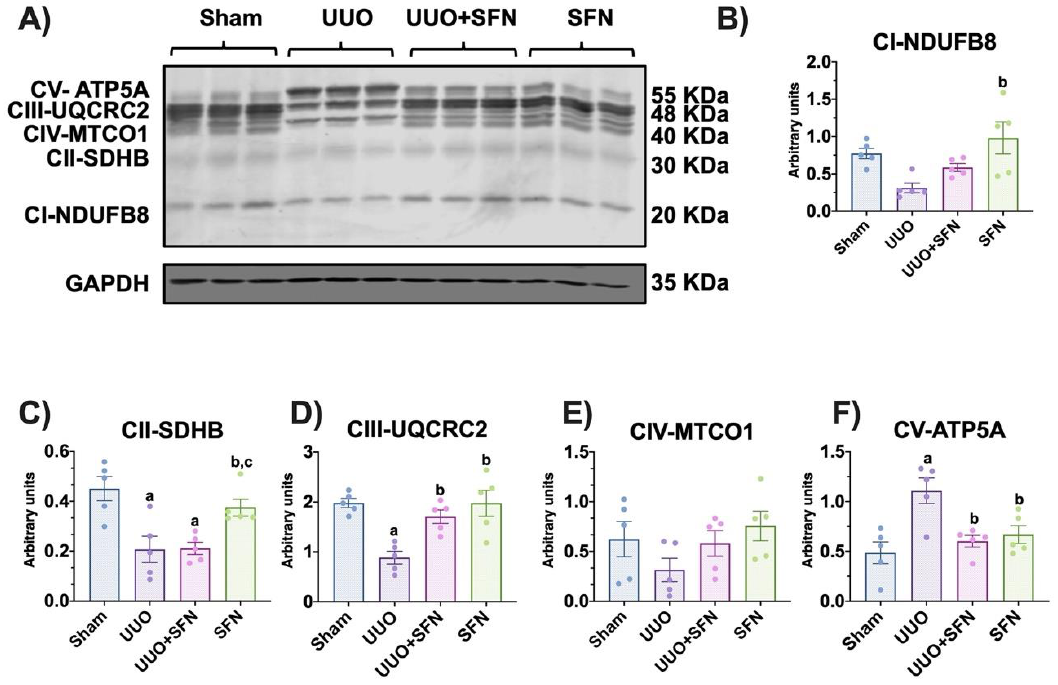
Figure 4. Effect of sulforaphane (SFN) on the levels of subunits of the electron transport system (ETS) complexes in the unilateral ureteral obstruction (UUO) model. ( A ) Representative immunoblotting and densitometric analysis of the levels of ( B ) the reduced form of nicotinamide adenine dinucleotide ubiquinone oxidoreductase subunit B8 (CI-NDUFB8), ( C ) succinate dehydrogenase complex iron-sulfur subunit B (CII-SDHB), ( D ) ubiquinol-cytochrome c reductase core protein 2 (CIII-UQCRC2), ( E ) cytochrome c oxidase subunit I (CIV-MTCO1), and ( F ) adenine triphosphate (ATP) synthase- α subunit (CV -ATP5A). Data are mean ± SEM, n = 5 per group, using a one-way ANOVA. Statistical differences were determined with multiple comparisons using Tukey’s test. Glyceraldehyde phosphate dehydrogenase (GAPDH) was used as a loading control. a p < 0.05 vs. Sham, b p < 0.05 vs. UUO, c p < 0.05 vs. UUO + SFN. Sham: simulated surgery without ligation of the ureter; UUO: unilateral ureteral obstruction with double ligating the left ureter for seven days; UUO + SFN: UUO treated with SFN (1 mg/kg, intraperitoneal); and SFN: administered with SFN (1 mg/kg, intraperitoneal).